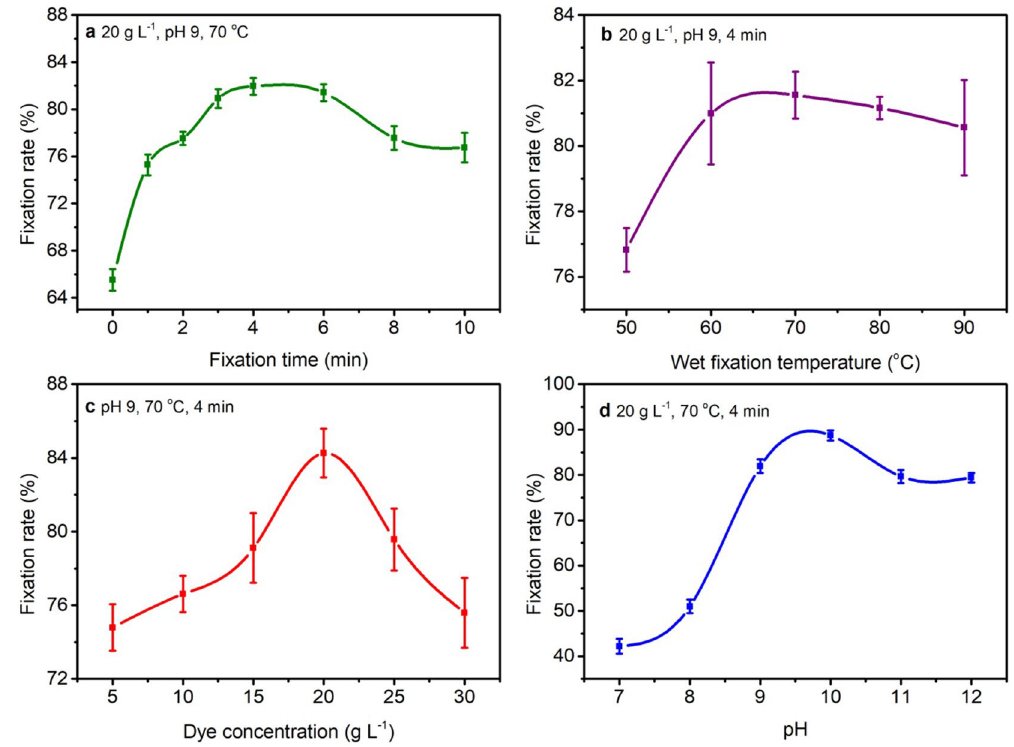
Figure 8. Influence of ( a ) wet fixation time, ( b ) wet fixation temperature ( c ) dye concentration, and ( d ) dye solution pH on fixation rate (%) of reactive dye on cotton